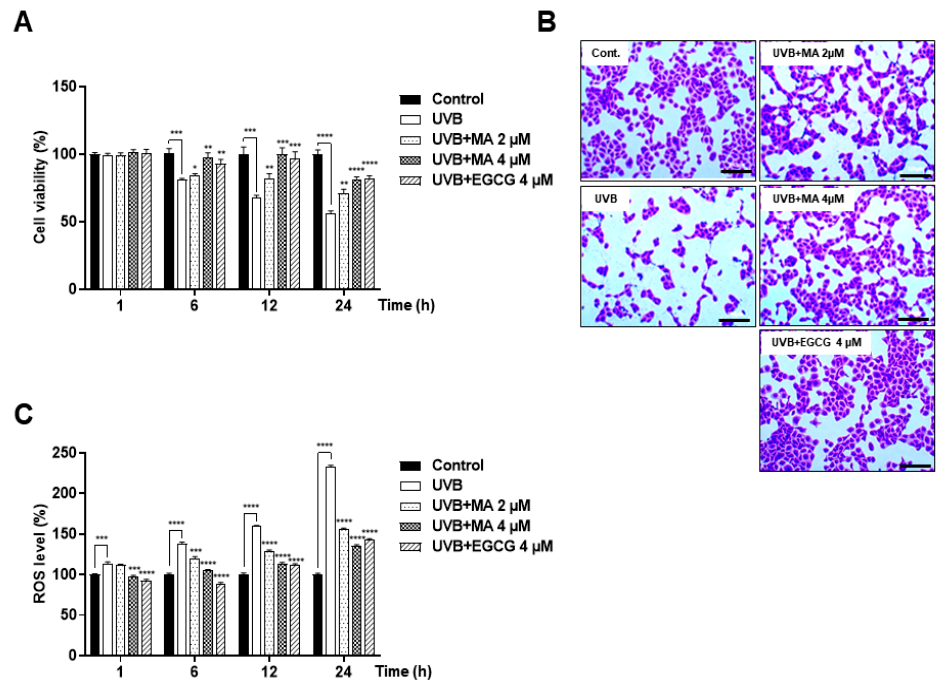
Figure 2. Effects of malonic acid (MA) on reactive oxygen species (ROS) levels and viability of ultraviolet (UV) B-irradiated HaCaT cells. HaCaT cells have been pre-treated with 2 or 4 µ M MA and 4 µ M epigallocatechin-3-gallate (EGCG) for 4 h and then exposed to UV-B irradiation (15 mJ/cm 2 ). After UVB irradiation, cells have been incubated for 1, 6, 12, and 24 h. ( A , B ) Protective effects of MA against UVB-induced cell death, as measured by WST-1 assay and crystal violet staining. Scale bars, 100 µ m. ( C ) Intracellular ROS levels induced by UVB-irradiation are measured using the 2 (cid:48) , 7 (cid:48) -dichlorodihydrofluorescein diacetate (DCF-DA) method. The data were analyzed in triplicate and displayed as the mean ± the standard error of the mean (SEM). (*) p < 0.05, (**) p < 0.01, (***) p < 0.001, and (****) p < 0.0001.